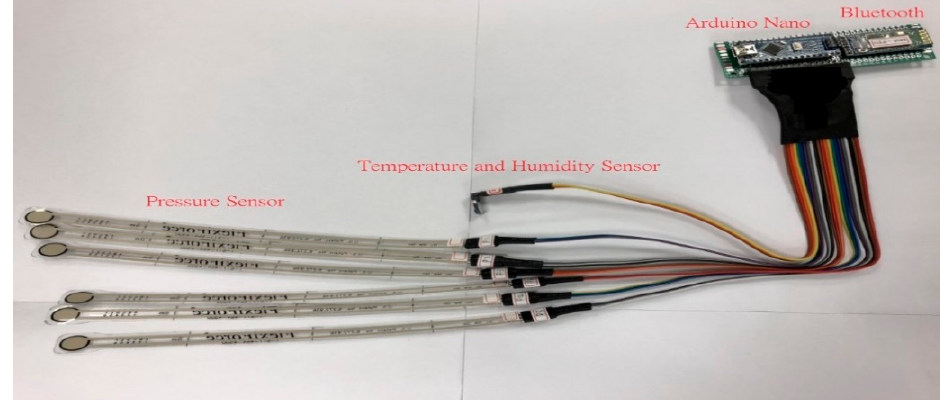
Figure 2. Sensing Figure 2. Sensing module.